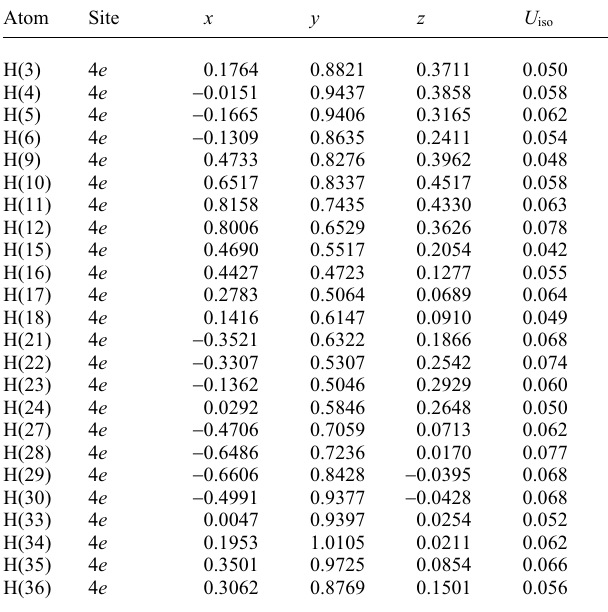
Table 2. Atomic coordinates and displacement parameters (in Å 2 ) .